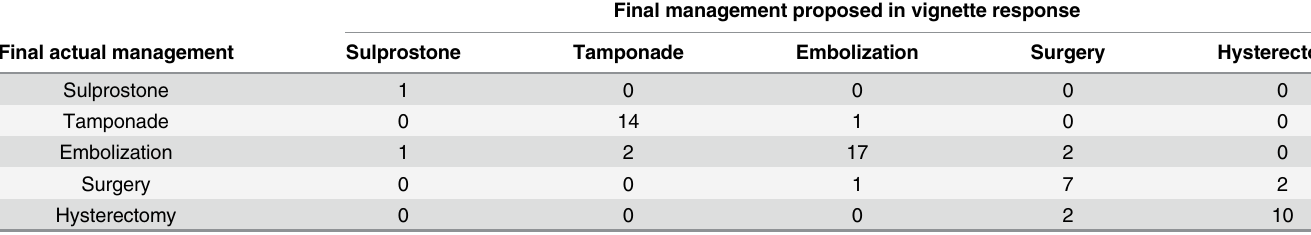
Table 1. Final agreement in cases previously managed by the